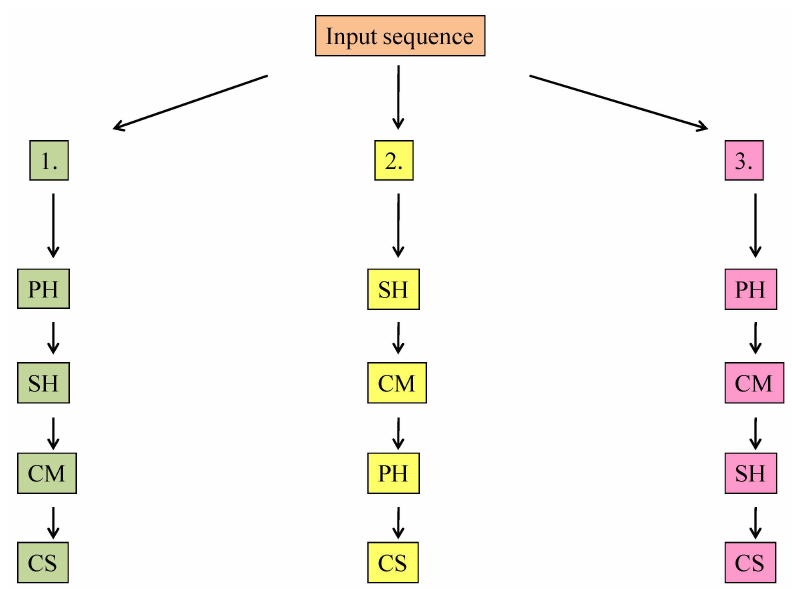
Figure 6. Changing the input sequence; PH: phenol; SH: sodium humate; CM: clay mineral; CS: cationic surfactant.